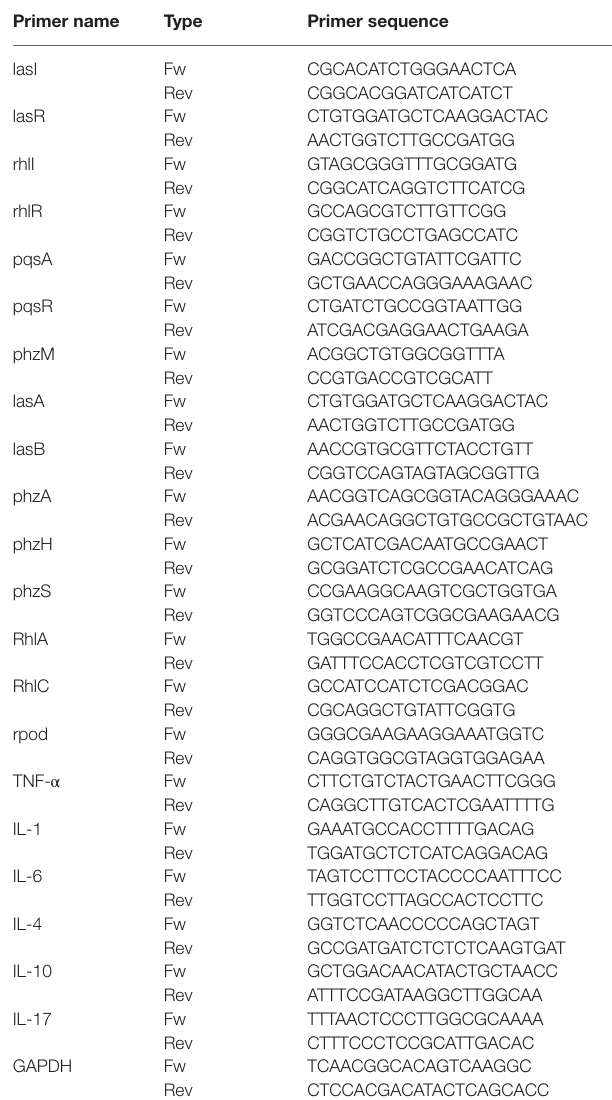
TABLE 1 | PCR primers of virulence factors and inflammatory